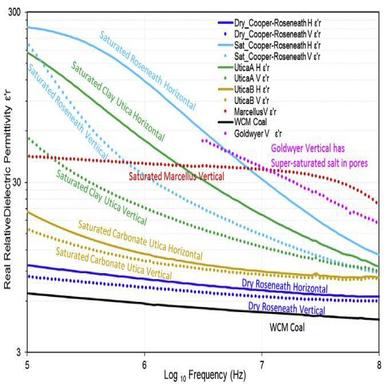
Real dielectric permittivity from a diverse collection of shales and a reference coal sample. Dielectric permittivity in the horizontal direction is systematically higher than in the vertical direction and the dielectric permittivity and anisotropy consistently increase with an increase in water content. The Goldwyer Formation shale (pink) has the highest dielectric permittivity of non-graphitized-bituminous samples presented, exhibiting a dispersive dielectric frequency response. However the Marcellus sam